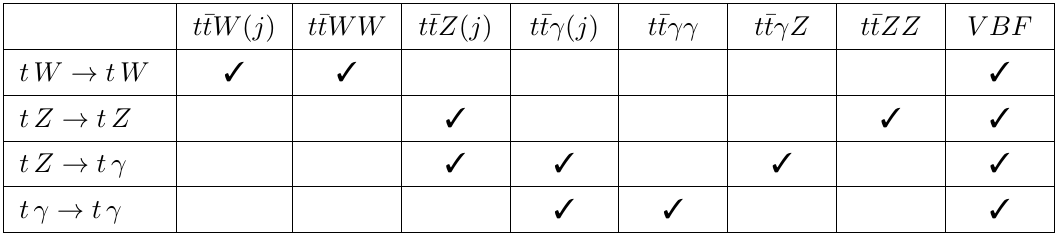
Table 6. The set of two-top 2 2 scattering amplitudes without Higgs bosons considered in this ! work mapped to the collider processes in which they are embedded.